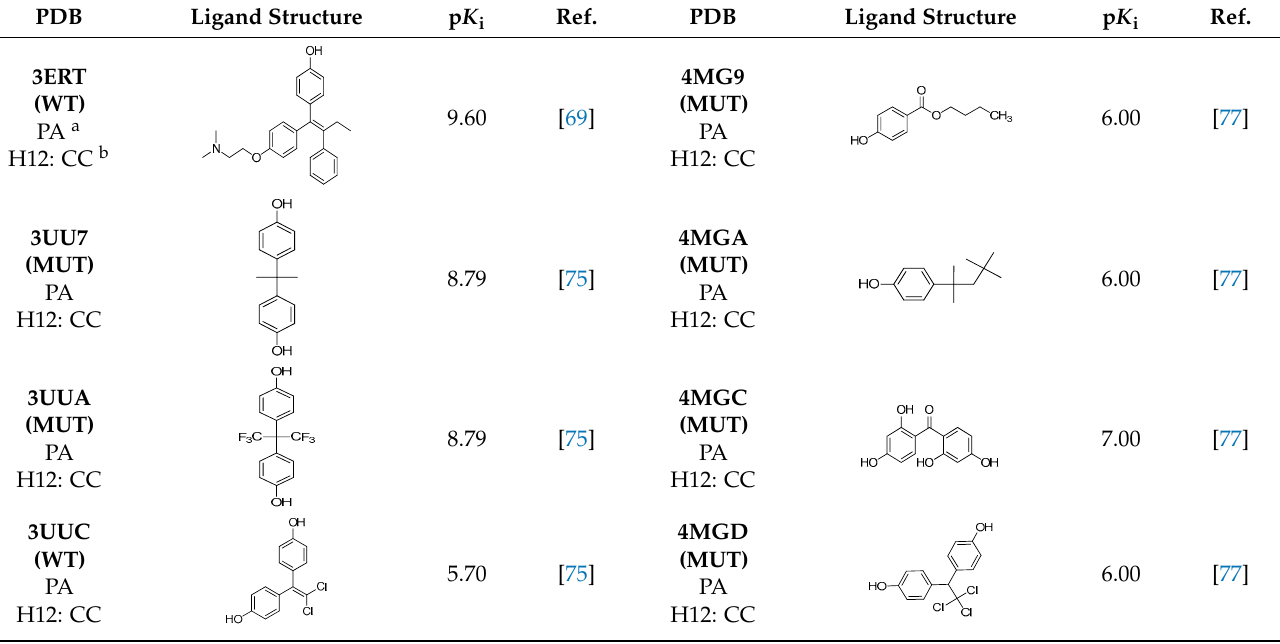
Table 3. PDB codes, ligand structures, and pharmacological profile of WT and MUT estrogen receptor α complexed (the qualification indicated below the code) with antagonists and partial agonists used as test set (TS CRY ).